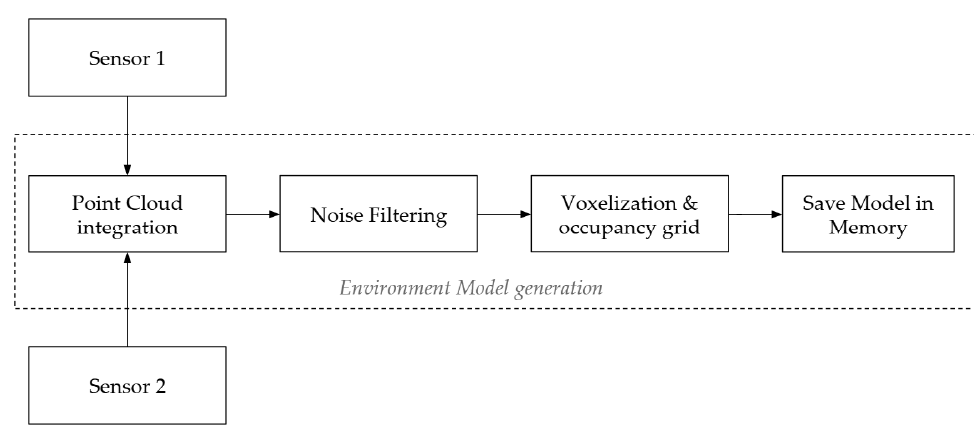
Figure 5. Processes to obtain the point cloud of the